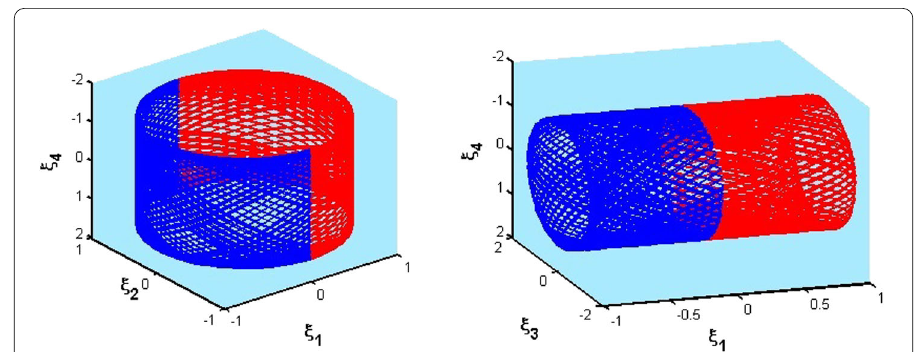
Figure 10 Invariant torus appears at K = 1.51